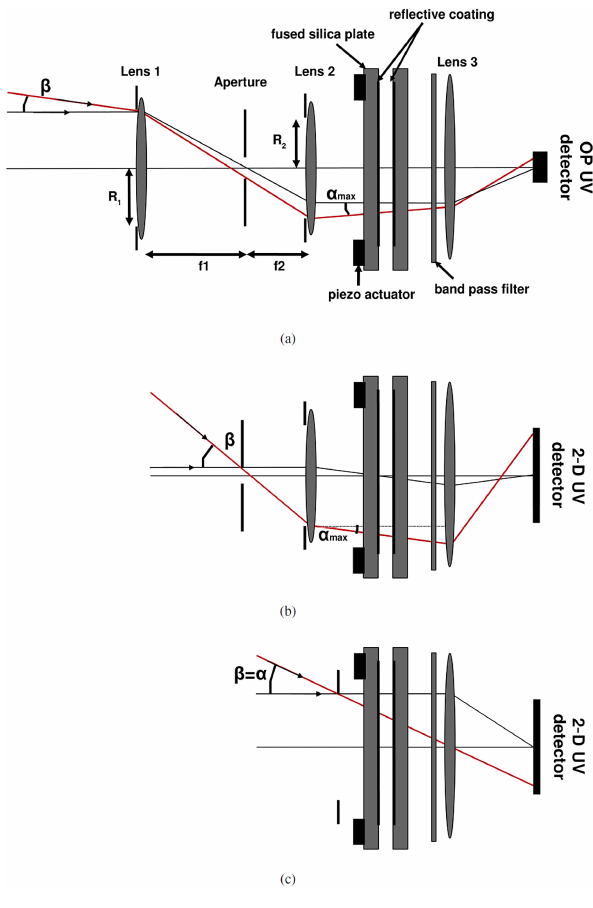
Figure 6. Three possible implementations of an FPI camera. In each setup, the FPI is implemented by two fused silica plates with reflec- tive coatings (reflectivity R) at the inner surfaces, whose separation d is tunable by piezo actuators. The outer surfaces either carry anti- reflective coating or are slightly tilted against each other to exclude additional interference effects. (a) One-pixel FPI instrument: two lenses (lens 1, lens 2) and an aperture determine the aperture angle (2 · β ) of the instrument, constrained by α max . Lens 3 projects the radiation onto a UV-sensitive OP detector after having passed the band-pass filter. 2-D data are achieved by scanning, either by ad- ditional optics or by tilting the whole device. (b) 2-D FPI camera, where radiation from FOV is parallelized before being projected onto a 2-D detector. (c) 2-D FPI camera, where radiation from FOV traverses the FPI under α = β for FOV ≈ 20 ◦ . More than two FPI settings are required to obtain non-vanishing sensitivity throughout the FOV (see Fig.